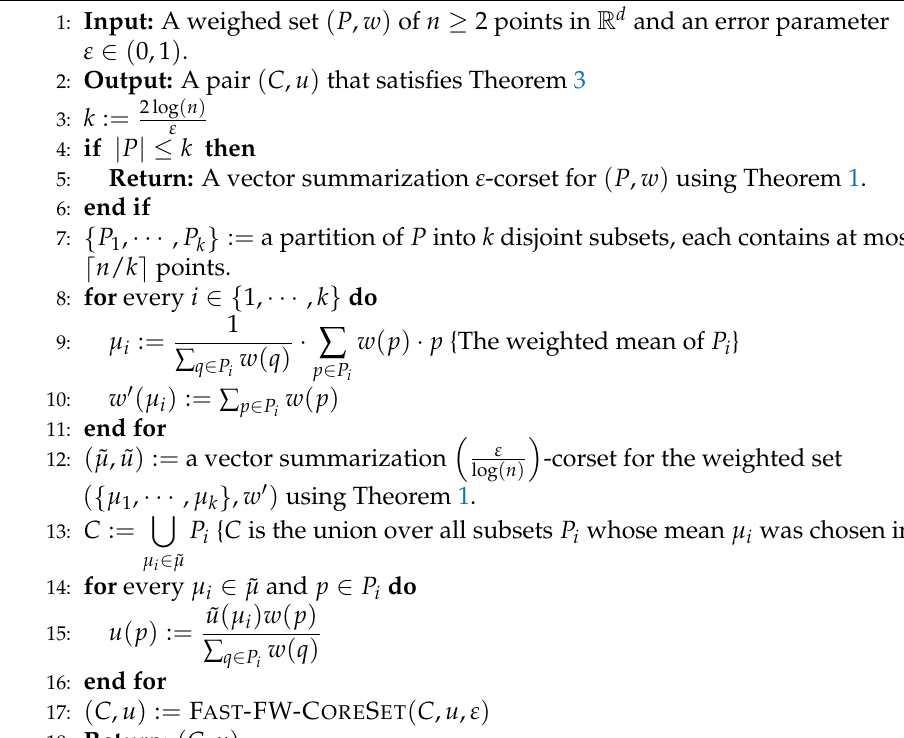
Algorithm 3: F AST -FW-C ORE S ET ( P , w , ε